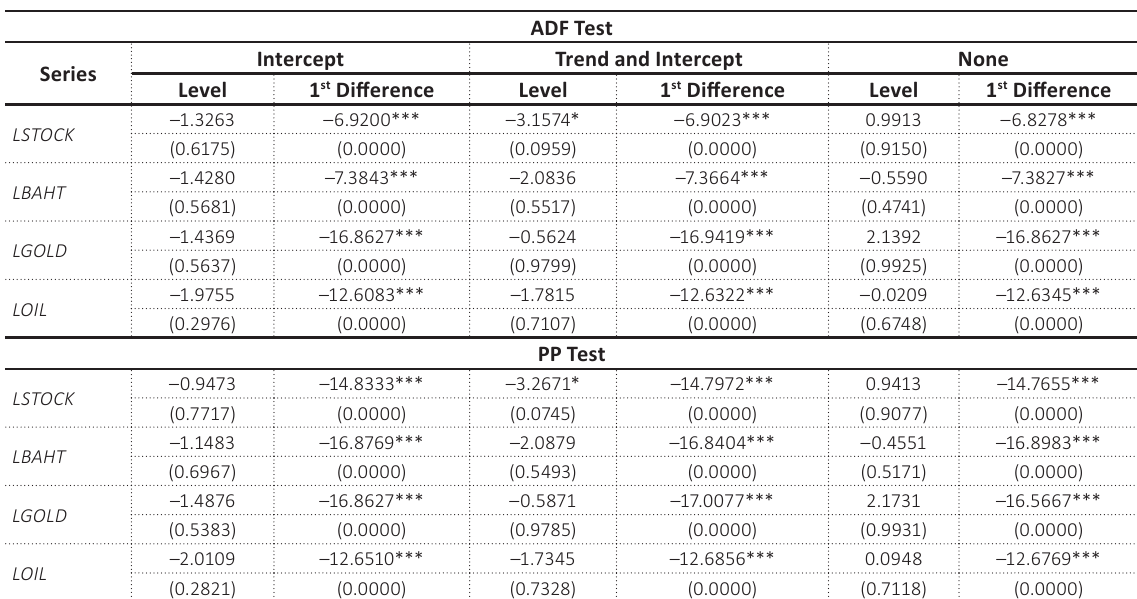
Table 1. Unit root tests